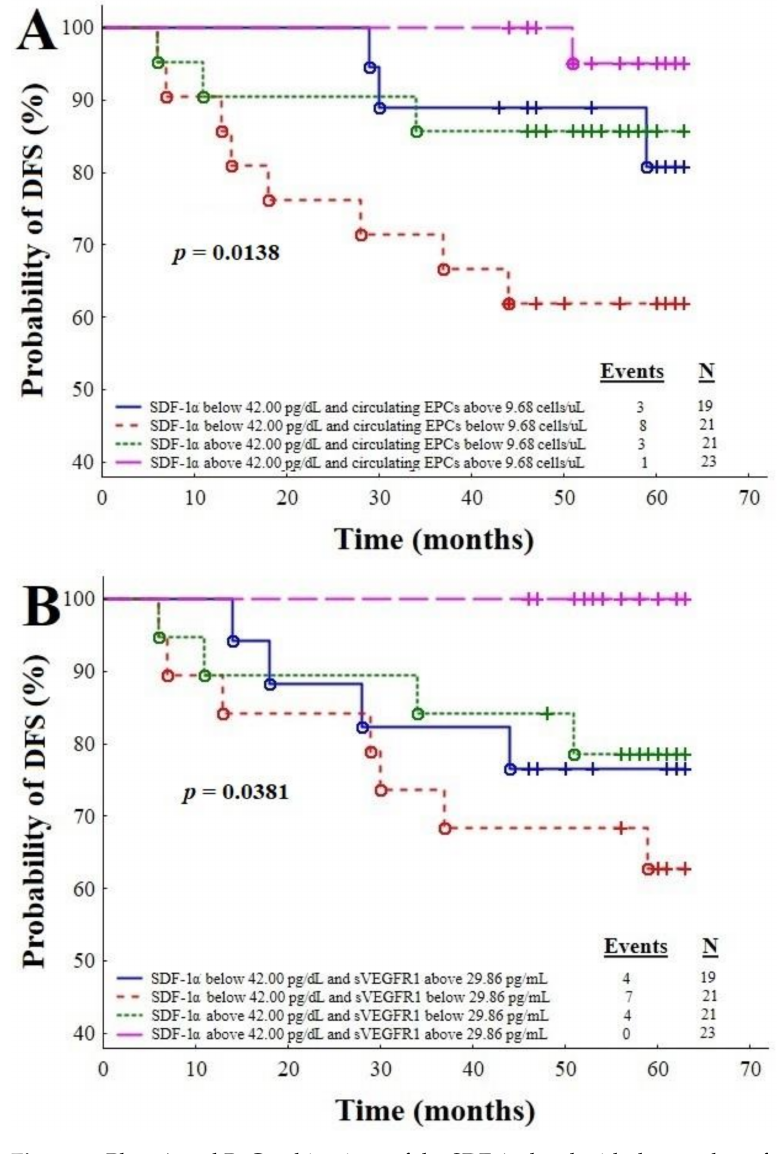
Figure 5. Plots A and B: Combinations of the SDF-1 α level with the number of circulating endothelial progenitor cells ( A ), and the SDF-1 α level with sVEGFR1 ( B ) in predicting disease